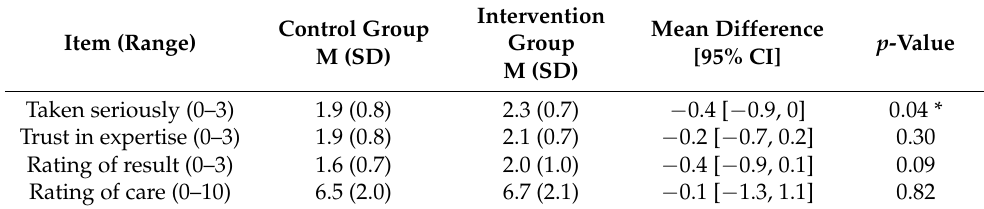
Table 4. Patients’ satisfaction with treatment (CQ-Index Module Pain).